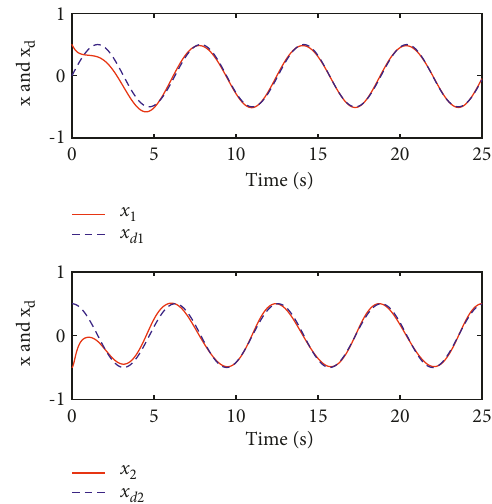
Figure 6: Tracking performance for uncertain system (44) with (34) (case